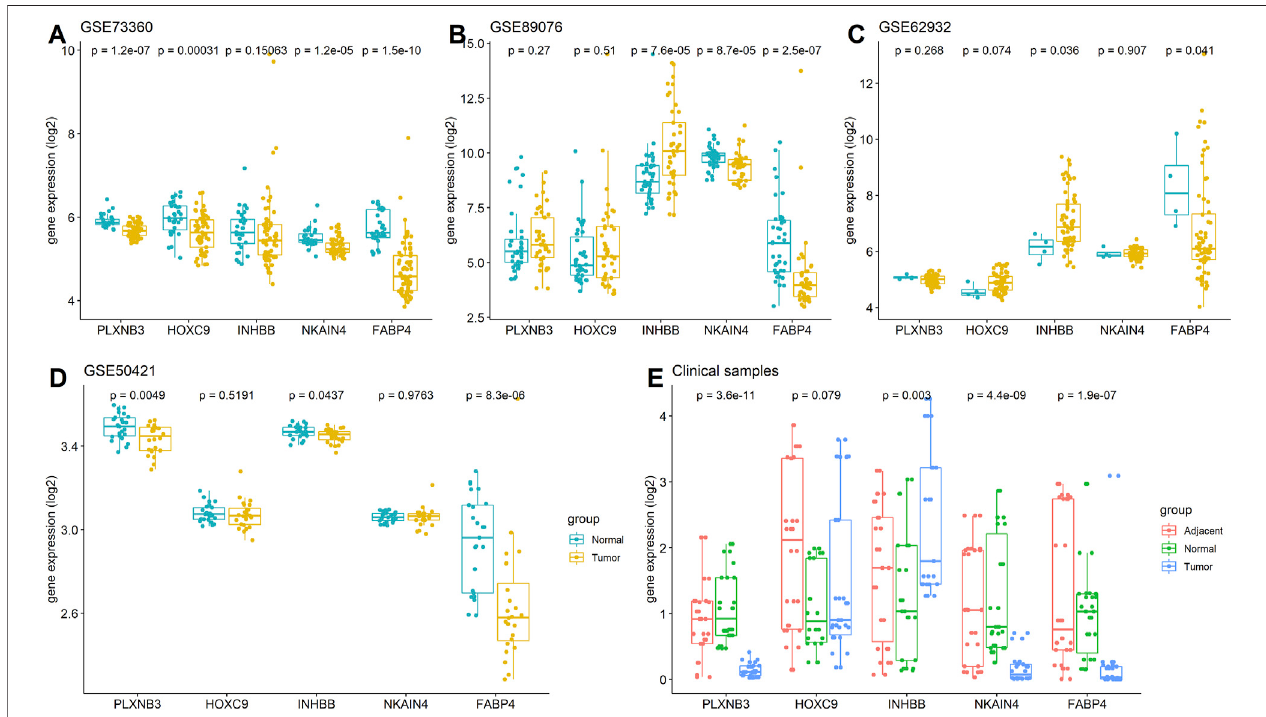
FIGURE 8 | Expressions of FABP4, HOXC9, INHBB, NKAIN4, and PLXNB3 in CRC. (A) GSE73360 dataset; (B) GSE89076 dataset; (C) GSE62932 dataset; (D) GSE50421 dataset; (E) Clinical tissue tested by RT-PCR assay.